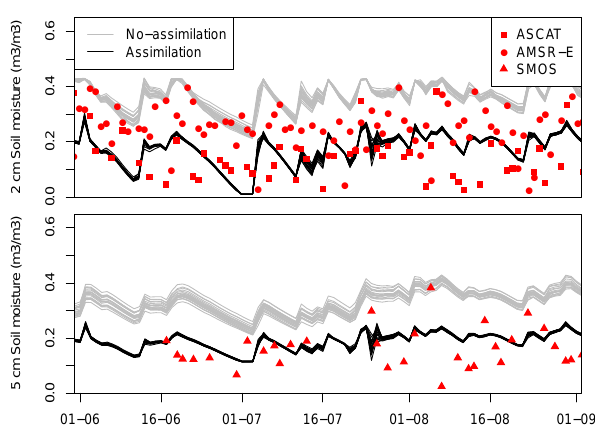
Figure A1. Example time series (14 ◦ E, 48 ◦ N) of simulated soil moisture for 0–2cm (upper panel) and the simulated soil moisture for 0–5cm (lower panel) for the analysis period, Q 7 sat scenario. Observations of remotely sensed soil moisture are shown from three different sensors. Jumps in the time series at assimilation moments indicate the update of model states according to the